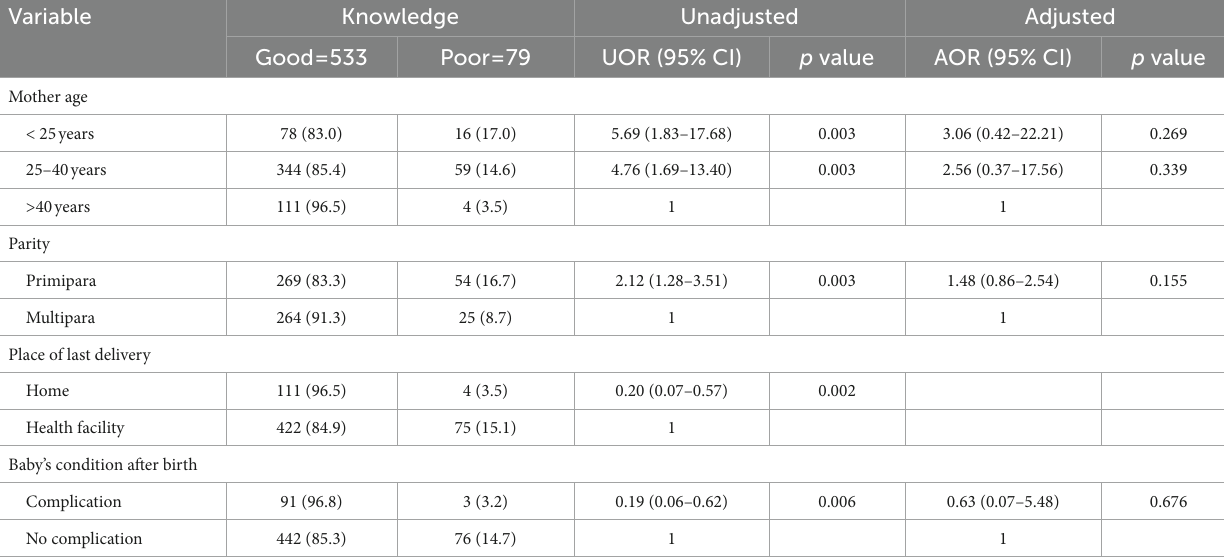
TABLE 5 Factors associated with knowledge of infection prevention in neonates.